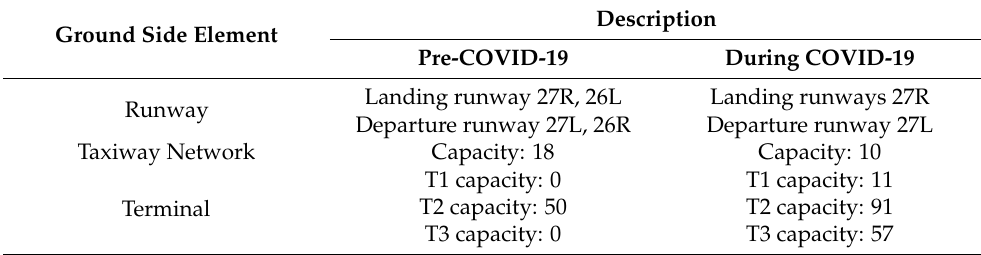
Table 1. Characteristics of the ground side element during